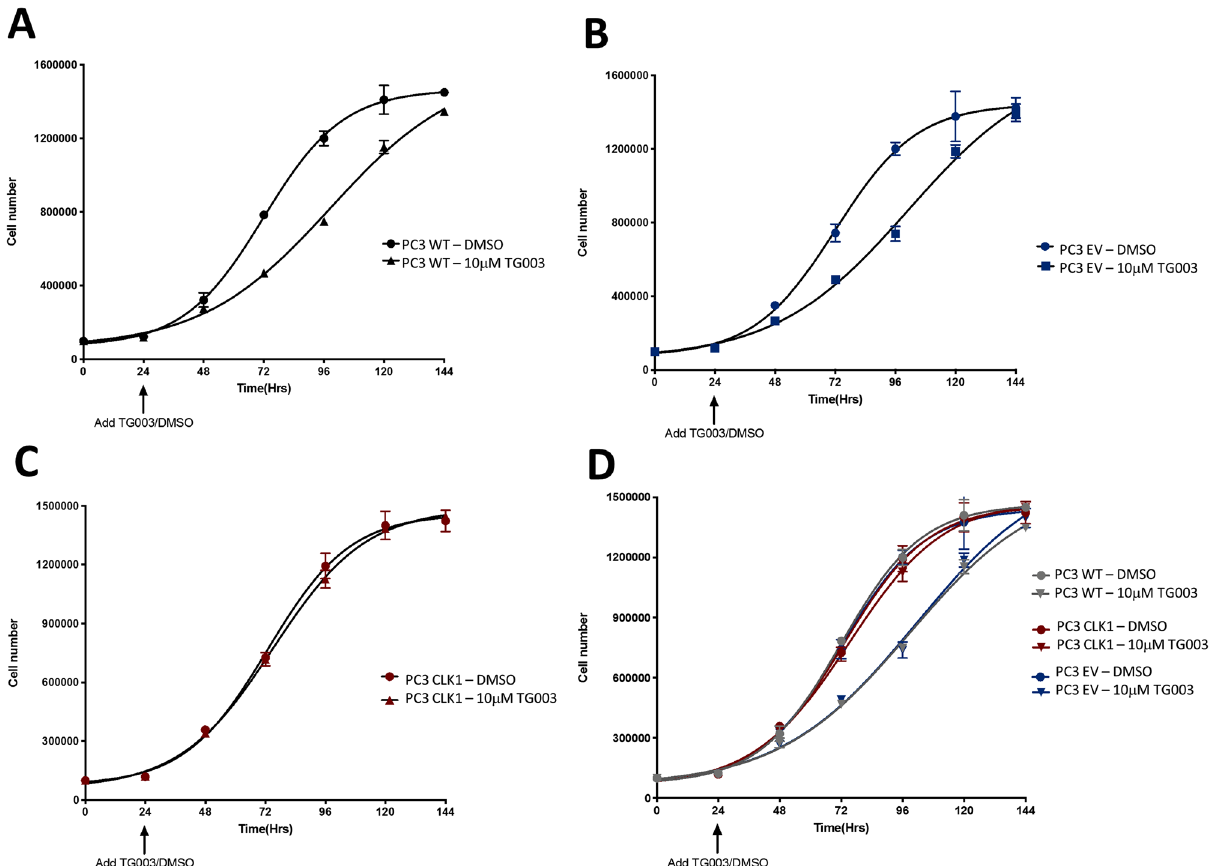
Figure 4. Stable CLK1 overexpression reduces TG003 sensitivity. 10,000 cells were seeded in 96-well plates and a single dose of 10 µM TG003 added after 24 h. Cells were counted every 24 up to 144 h (Alamar Blue assay); DMSO alone and TG003-treated. ( A ) Wild-type (WT) cells; ( B ) PC3 cells stably transfected with empty vector (EV); ( C ) PC3 cells stably transfected with a CLK1-expressing vector; ( D ) combination of the three. N = 3, **** p < 0.001, two-way